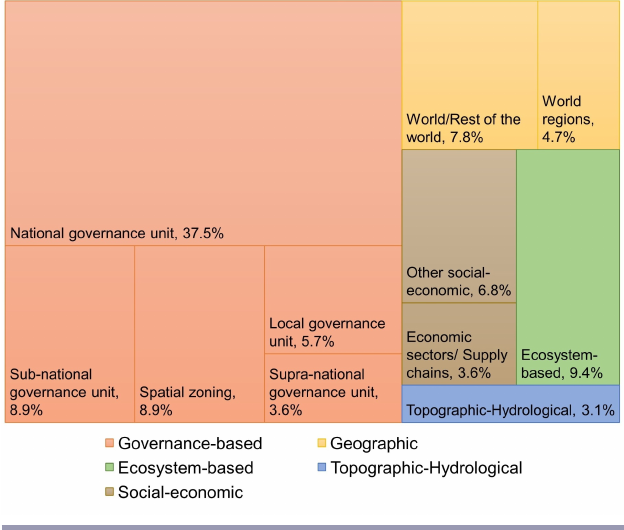
Fig. 6 . System boundaries used in telecoupling